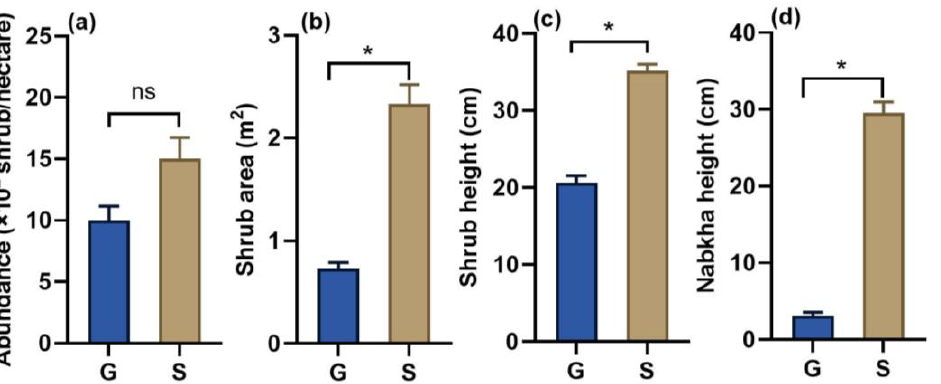
Figure 5. Shrub abundance ( a ), shrub area ( b ), shrub height ( c ) and nabkha height ( d ) of Caragana stenophylla in grassland and sandy land (mean ± SE). G, grassland; S, sandy land. * indicate significant differences between grassland and sandy land, p < 0.05, ns indicates not significant difference, p > 0.05, t -test or GLMMs.